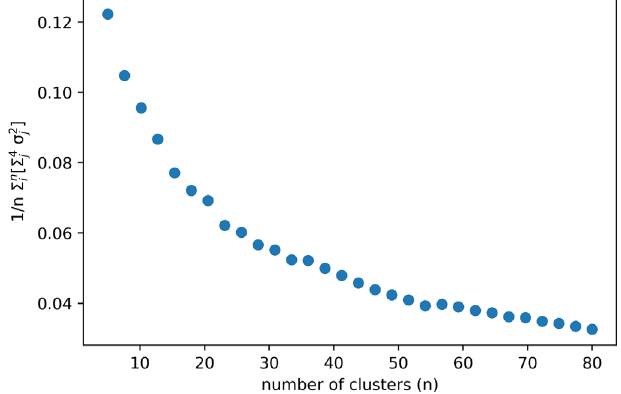
FIG. 15. Mean standard deviation of objective cluster as a function of the number of clusters.